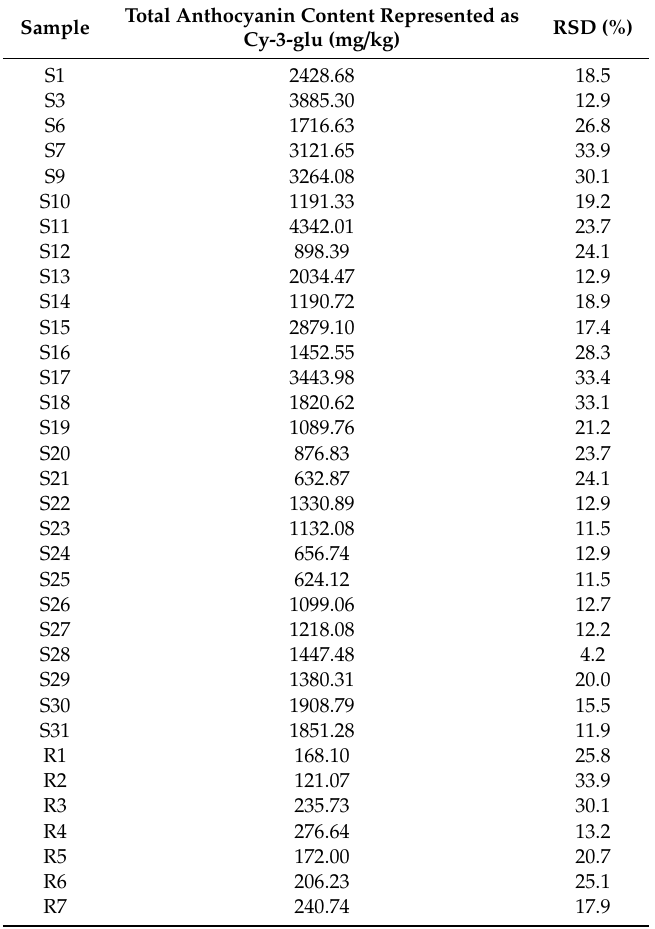
Table 2. Total anthocyanin content determined by pH-di ff erentiation method.